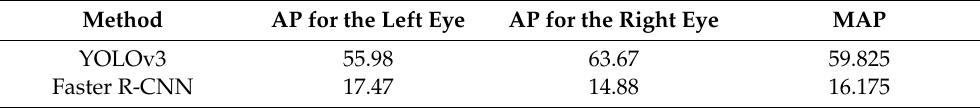
Figure 10. Precision – recall curves of the left and right eyes of the YOLOv3 model. Table 1. Numerical results of evaluation metrics for YOLOV3 and Faster-RCNN eye detection